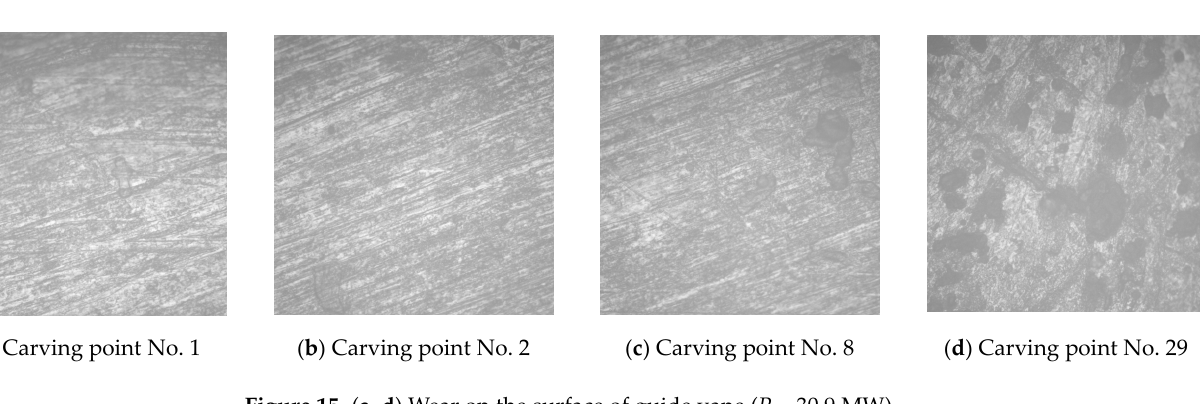
Figure 14. ( a – d ) Wear amount at different scoring points ( P = 42.8 MW).